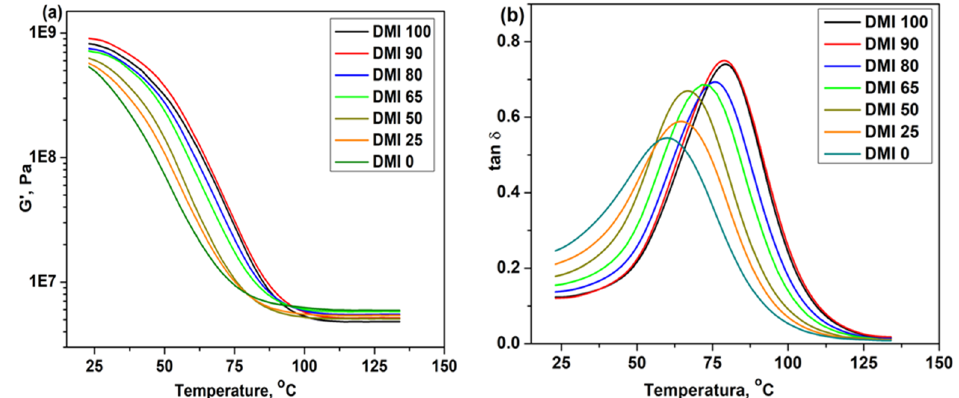
Figure 4. The dependence of storage modulus ( a ) and tan δ ( b ) on temperature in prepared samples. The lowest crosslink density was determined for the sample cured with pure